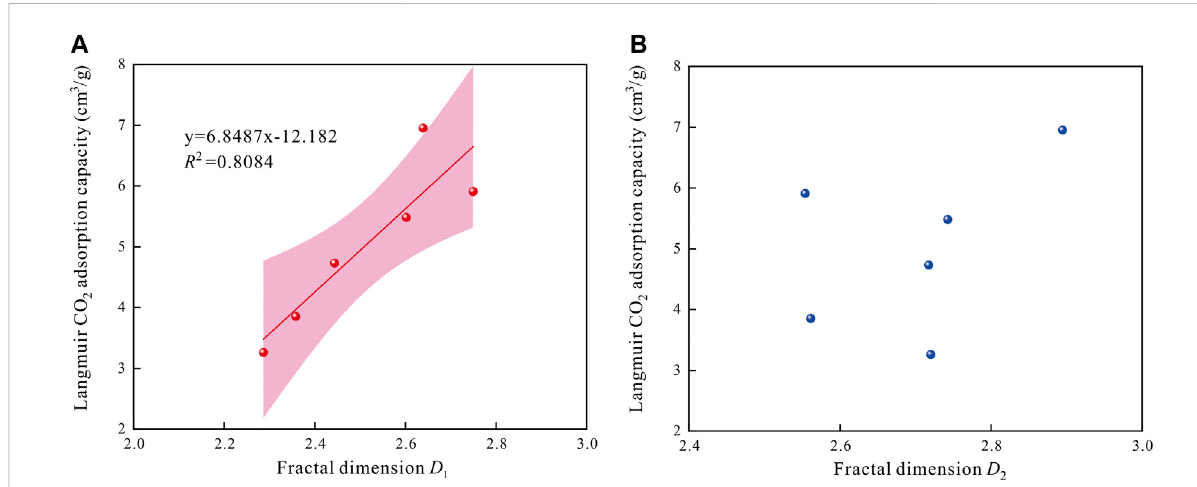
FIGURE 11 Relationships between fractal dimension and Langmuir CO 2 adsorption capacity in